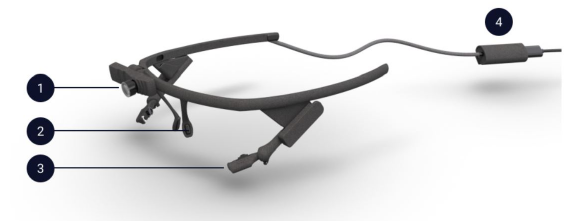
Figure 1. Pupil Core headset: ( 1 ) World Camera, ( 2 ) Nose Support, ( 3 ) Eye Cameras and ( 4 ) USB-C connector clip.